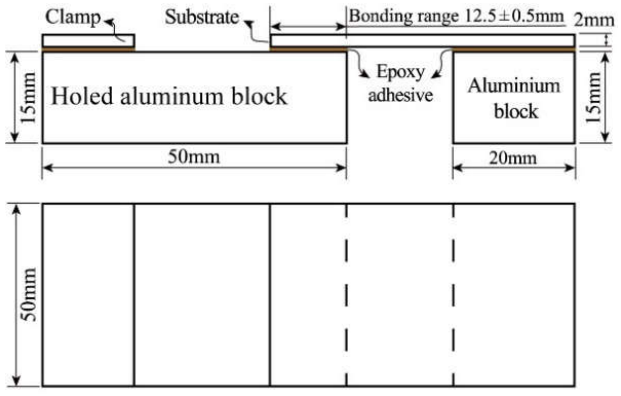
Figure 4. The geometry and dimensions of an SLJ.